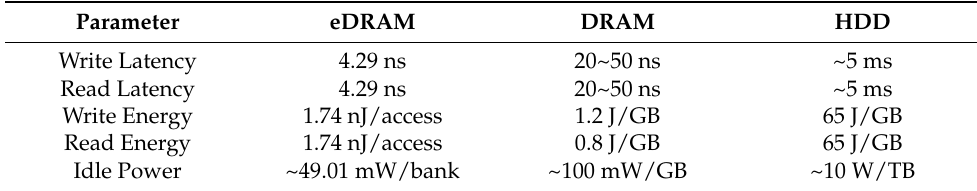
Table 3. Simulation Parameters.